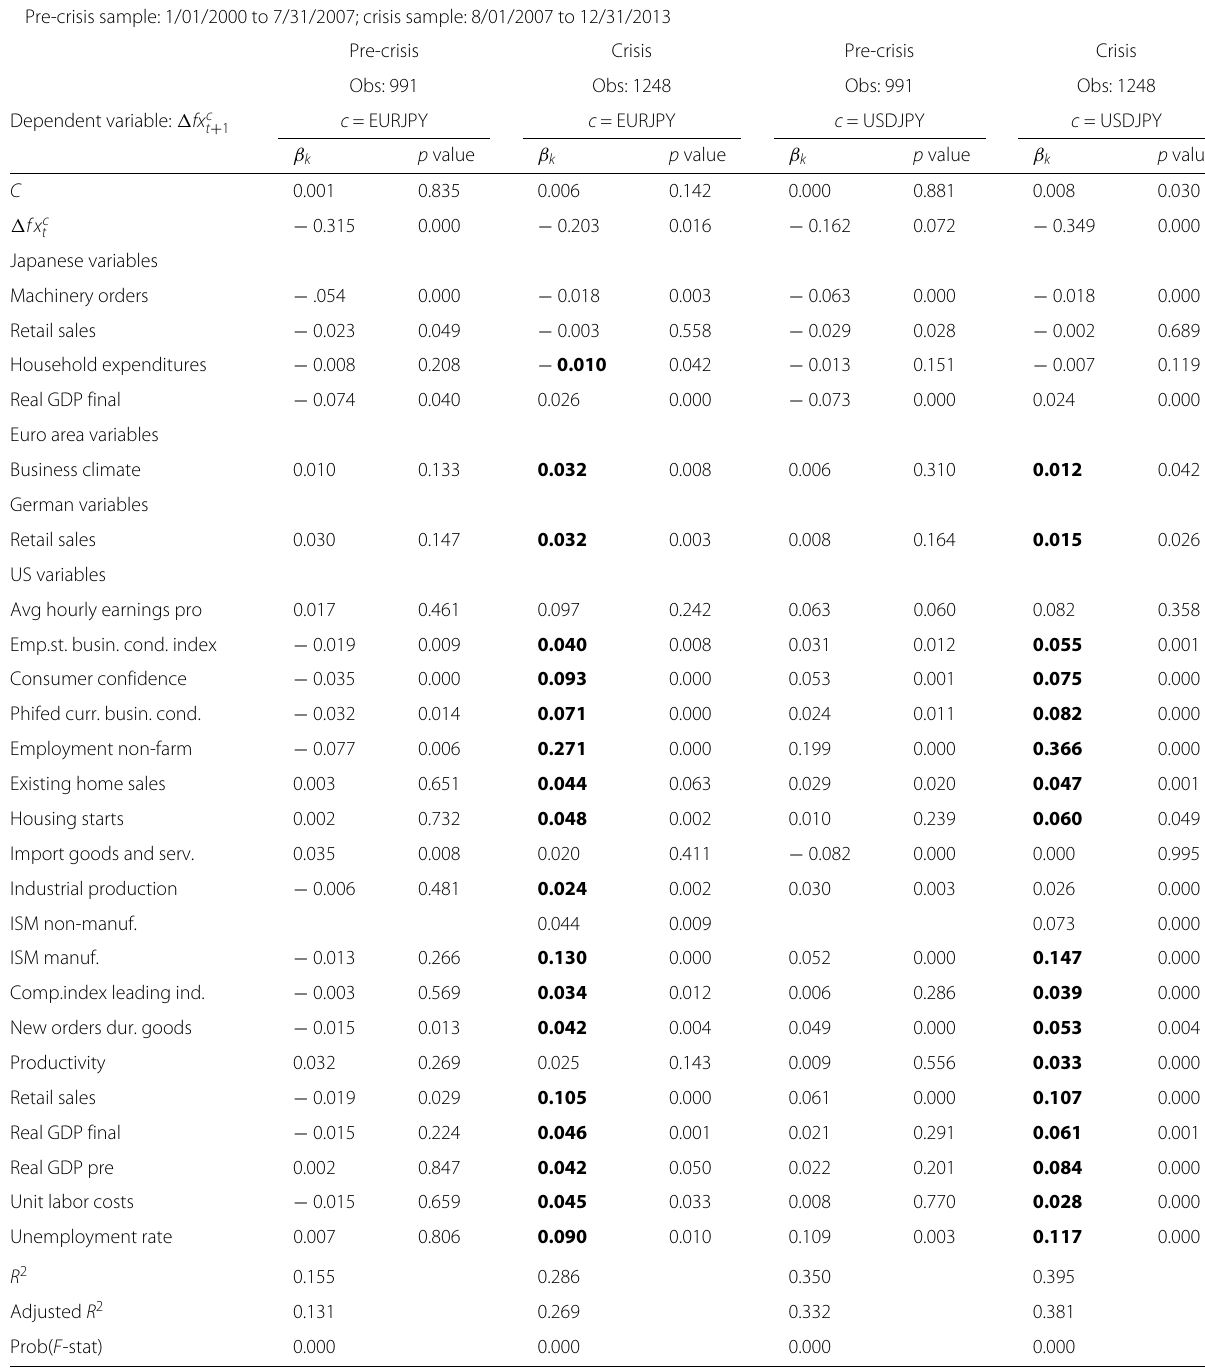
Table 4 Crisis vs. pre-crisis for the